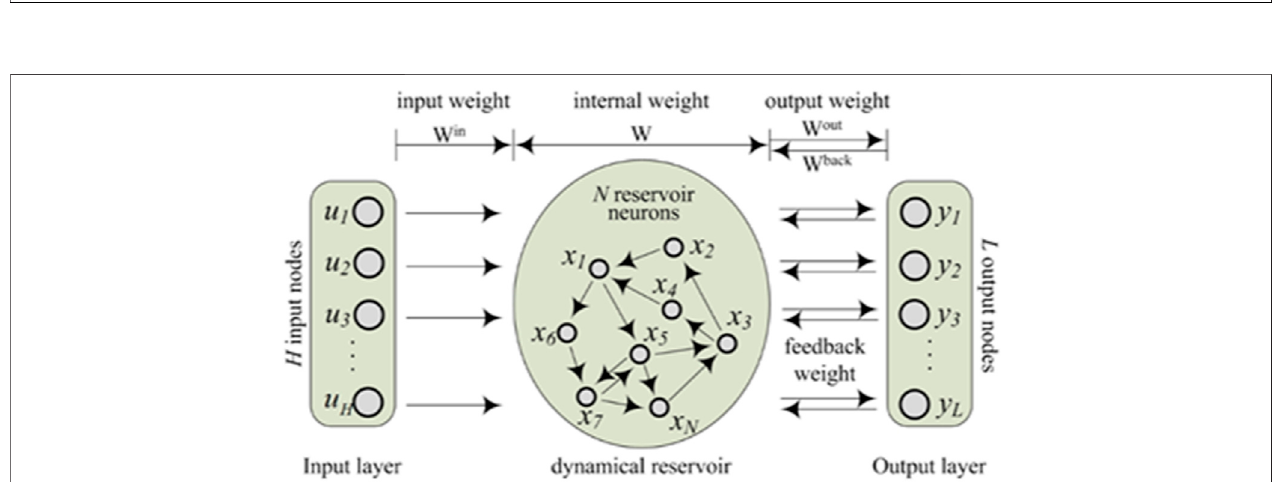
FIGURE 7 | Schematic architecture of algorithm implementation.